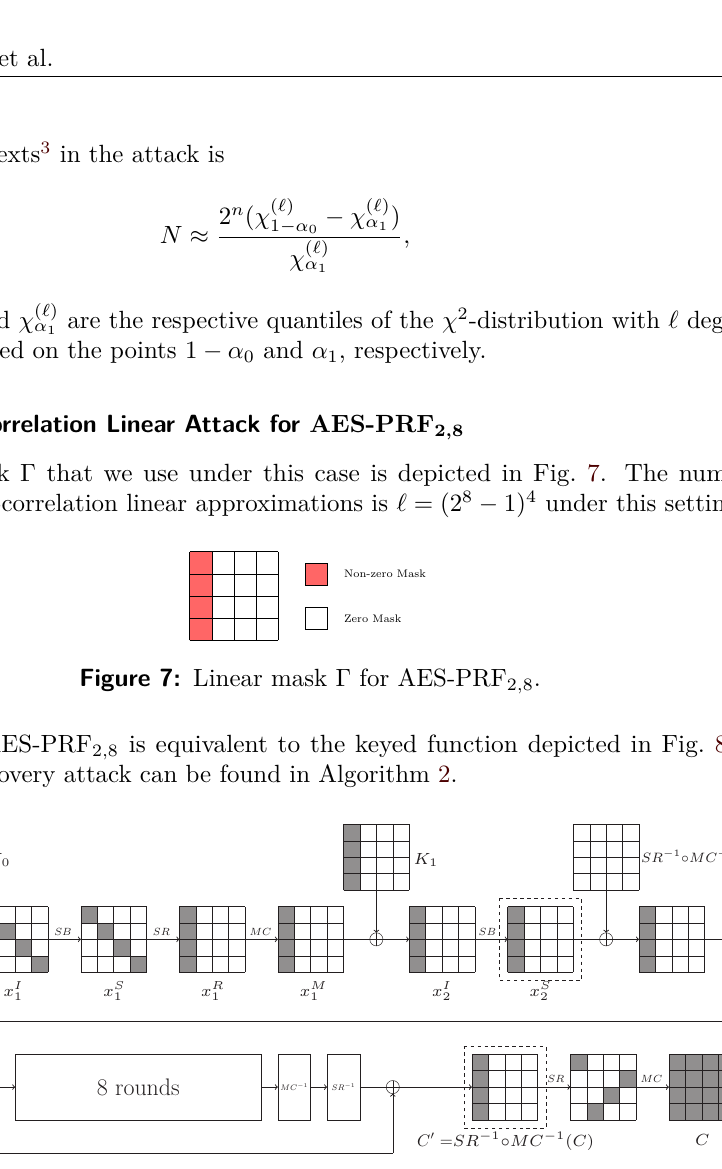
Figure 8: Zero-correlation attack for AES-PRF 2 , 8